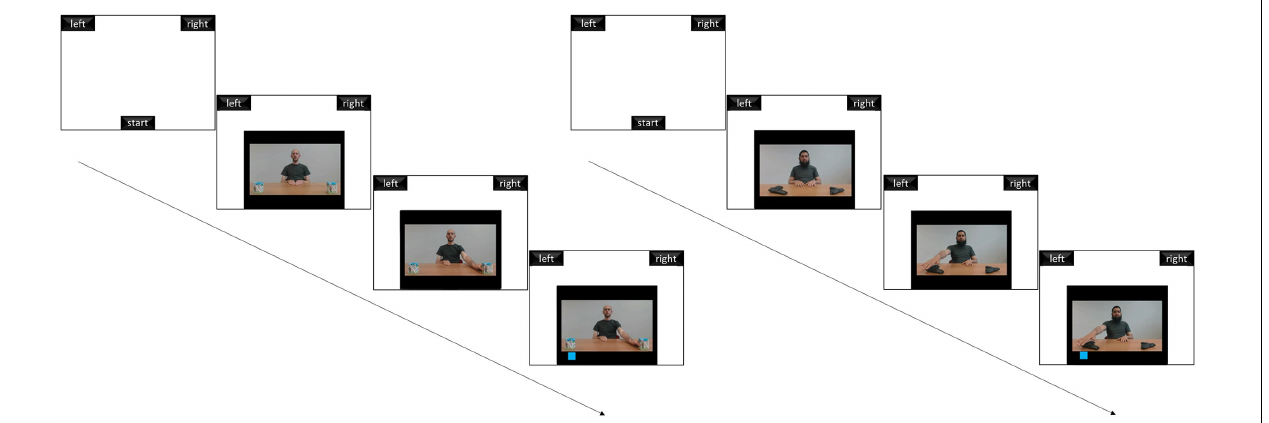
FIGURE 1 | An example of the experimental